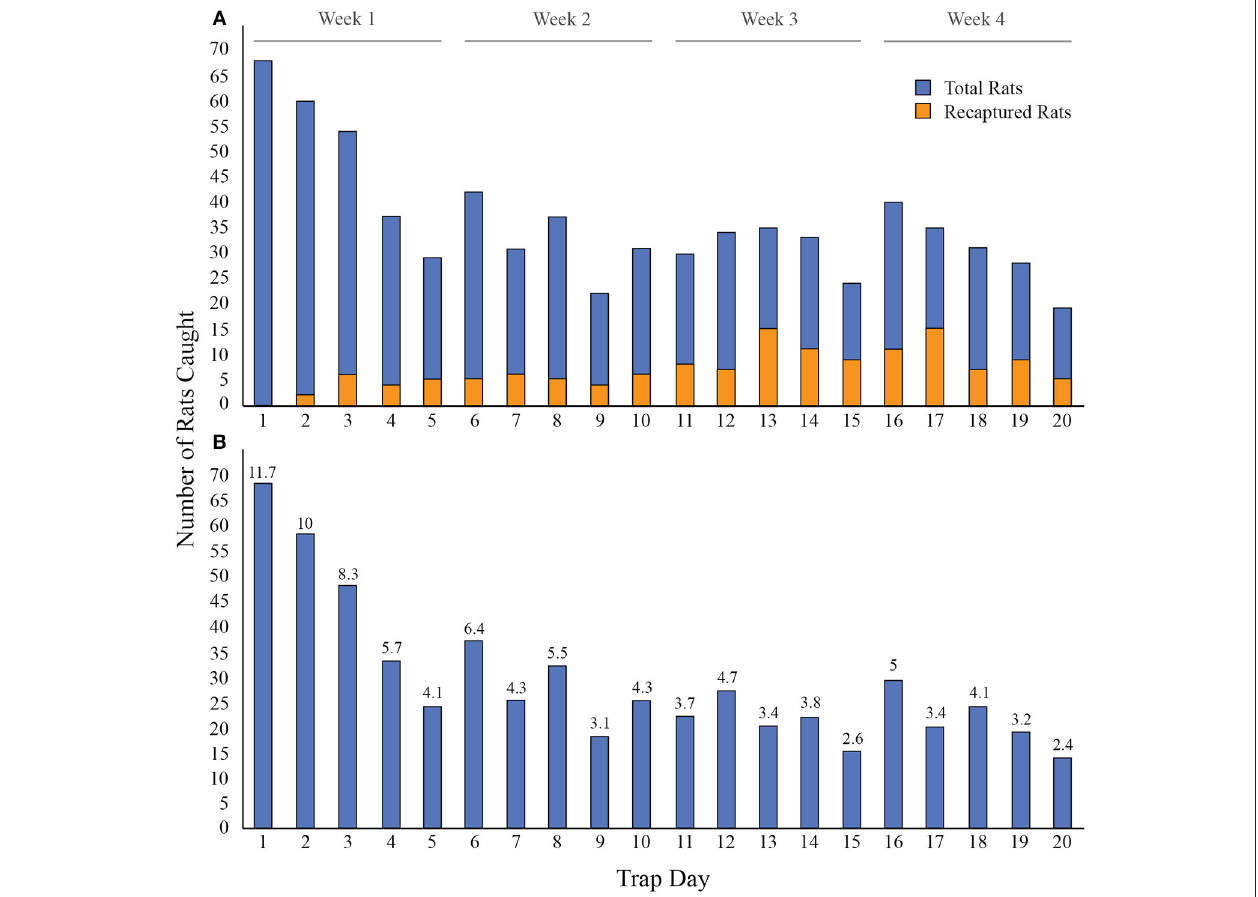
FIGURE 2 | Norway rats caught each day over 20 days in 31 city blocks of Vancouver, Canada. A. The number of rats caught each day, including rats caught only once (blue) and rats that were recaptured (orange), for a total of 720 rat capture events. B. The number of new rats caught each day (i.e. without recaptured rats). The percentage of rats caught out of the total number of individual rats (n = 580) is displayed on the top of each bar for each trap day (e.g., 11.7% of individuals were caught on day